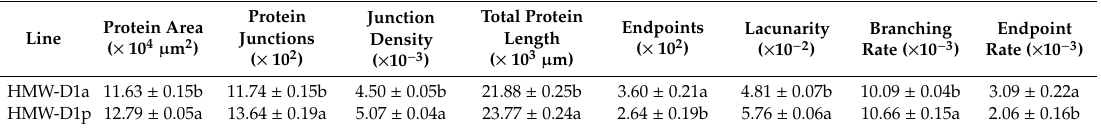
Table 1. Parameters analyzed using AngioTool for the protein network in dough obtained from the HMW-D1a and HMW-D1p flour.